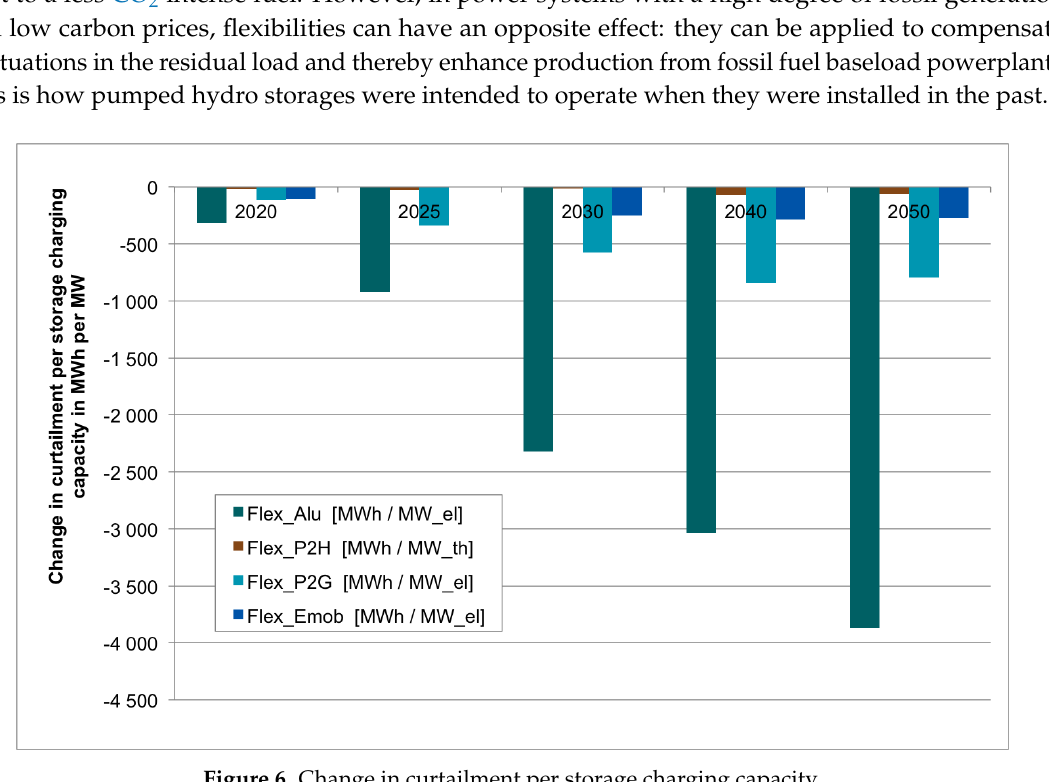
Figure 6. Change in curtailment per storage charging